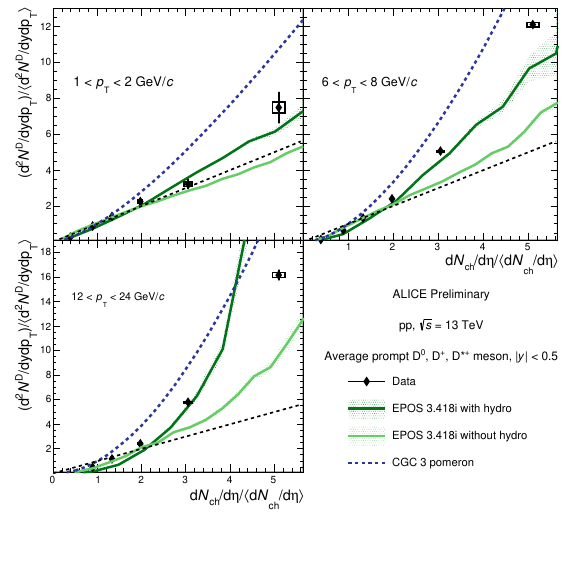
/ D 0 ratio shows a significant increase from the lowest c